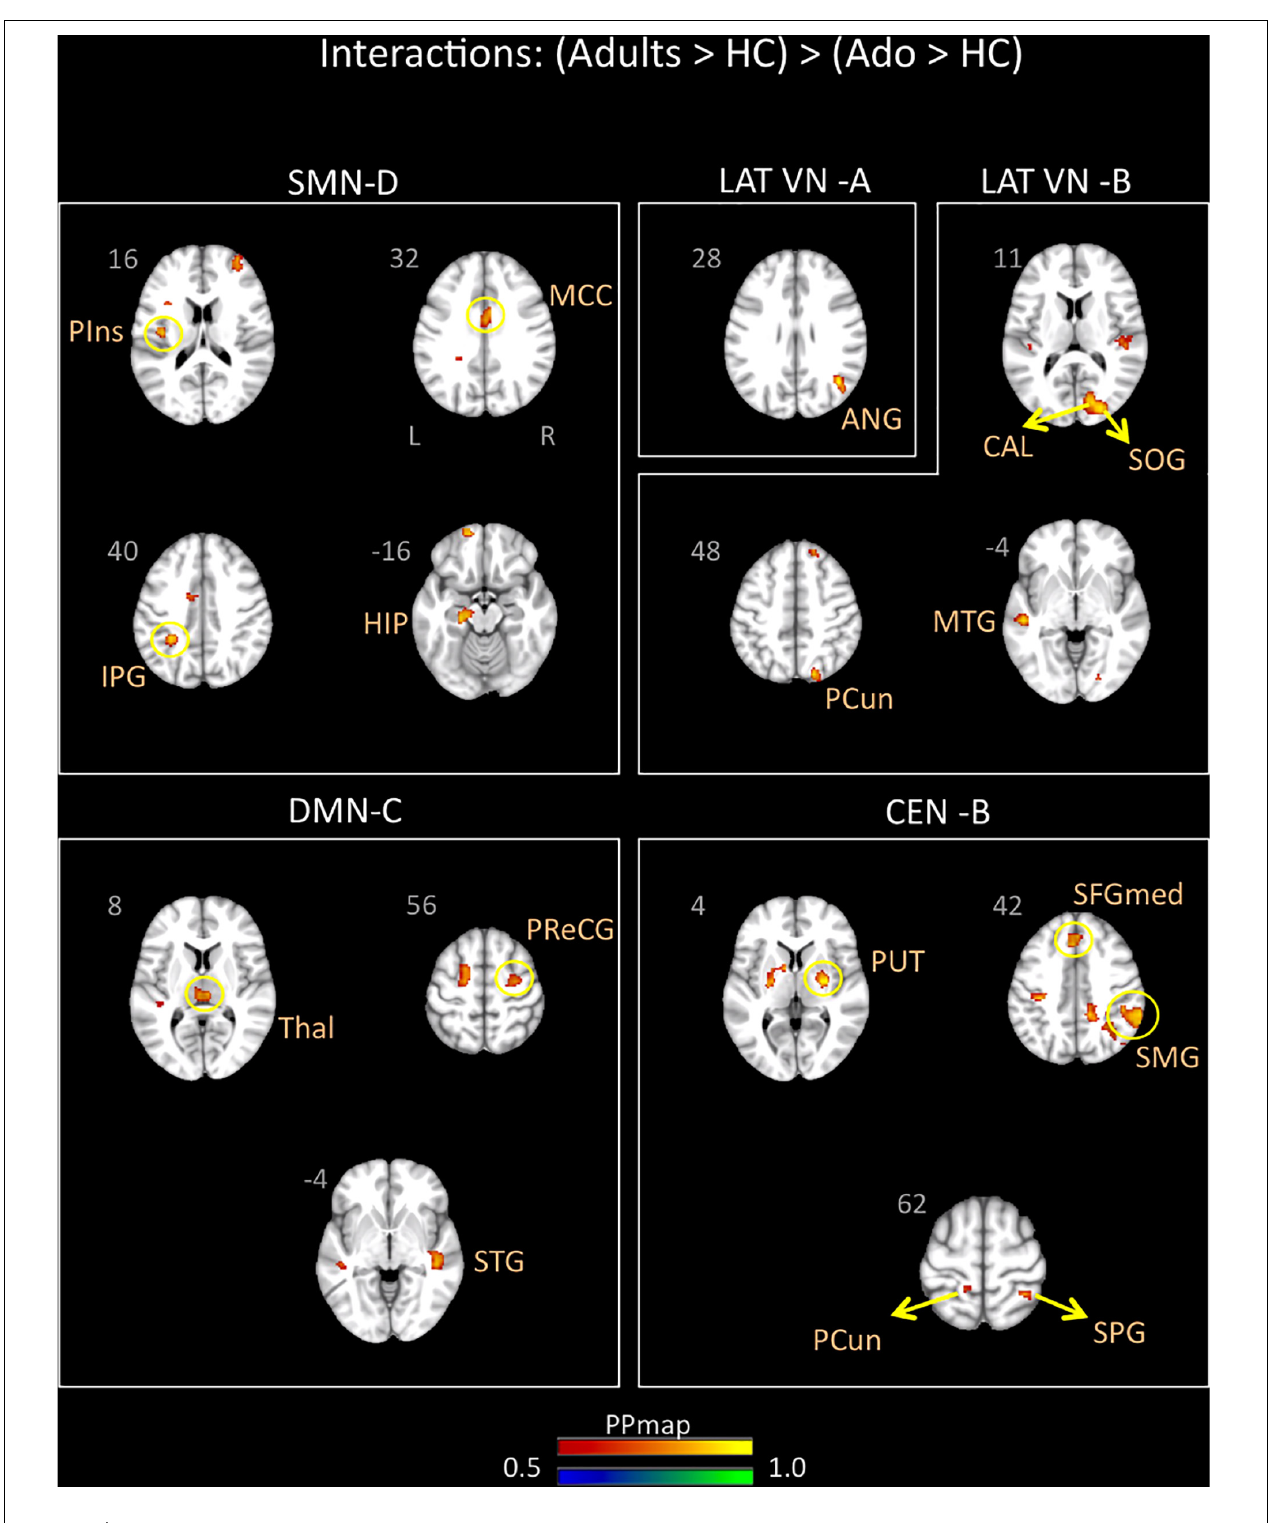
FIGURE 5 | Interaction of disease effect by age [young adults (Adults > HC) > adolescents (Ado > HC)]. The figure summarizes the statistically significant greater rs-FC in young adults with migraine in comparison to adolescents with migraine and their healthy controls. Greater connectivity was found in the sensorimotor D, lateral visual A and B, default mode C, and central executive B networks. See text for further details and Table 7 . Numbers refer to the standard MNI Atlas coordinates. Abbreviations of brain regions are described in Table 8 . Red – Yellow: Increased connectivity in adult migraineurs vs. adolescent migraineurs and their respective healthy controls. Blue – Green: Decreased connectivity in adult migraineurs vs. adolescent migraineurs and their respective healthy controls.